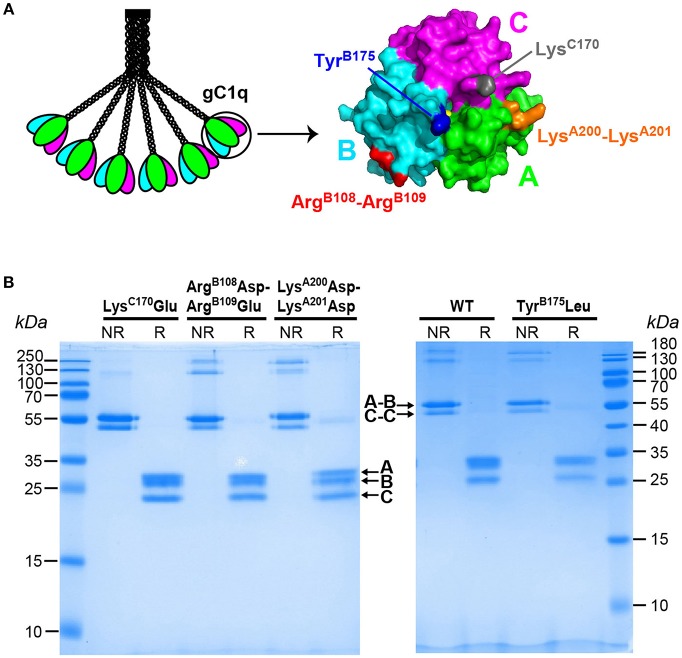
Location of the mutated residues on gC1q structure and SDS-PAGE analysis of the C1q variants. (A) Schematic representation of the C1q molecule and 3-D structure of C1q globular domain (gC1q) with C1qA (pink), C1qB (cyan), and C1qC (green). The location of the mutated residues is indicated on the gC1q heterotrimer structure [figure generated using the Mac Pymol software; PDB ID 2wnv (35)]. TyrB175 and LysC170 are located at the apex of the gC1q heterotrimer and LysA200-LysA201 and ArgB108-ArgB109 are located on the side surfaces of the gC1qA and gC1qB modules, respectively. (B) SDS-PAGE analysis and Coomassie blue staining of the C1q variants, under non-reducing (NR) and reducing (R) conditions.